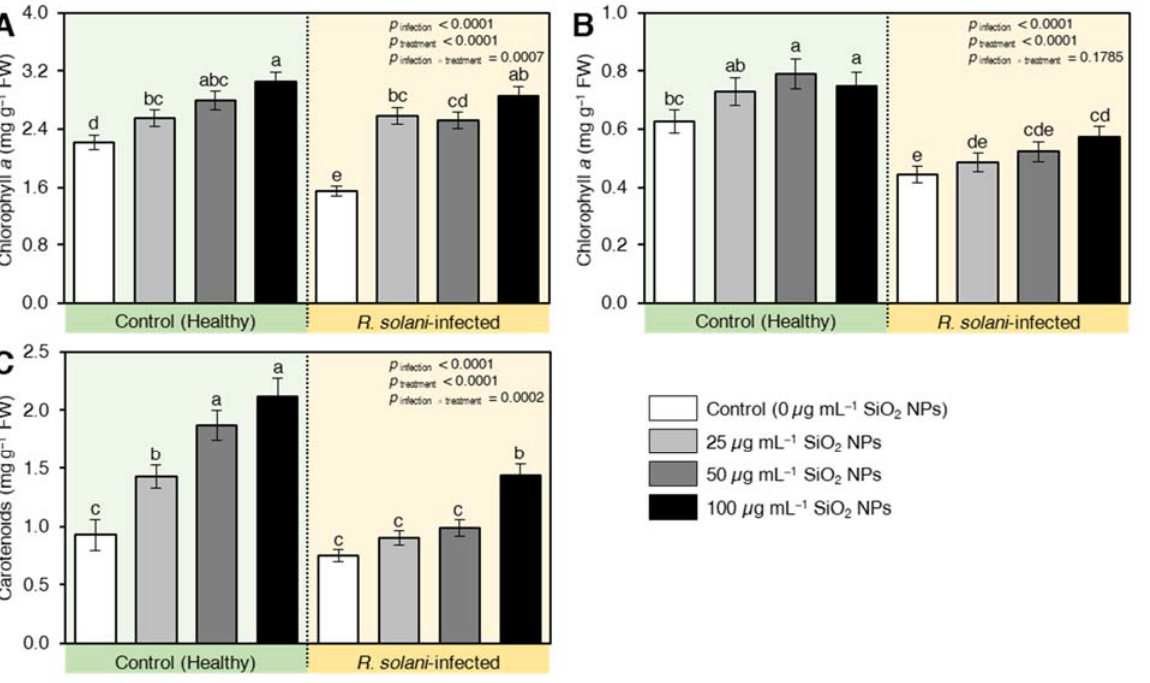
Figure 6. Effect of silicon dioxide nanoparticles (SiO 2 NPs) on the content of photosynthetic pigments of wheat seedlings infected by R. solani. ( A ) Chlorophyll a (mg g − 1 FW), ( B ) Chlorophyll b (mg g − 1 FW), and ( C ) Carotenoids (mg g − 1 FW). Data presented are means ± standard deviation (mean ± SD) of five biological replicates. Different letters indicate statistically significant differences among treatments, while the same letters signify no significant differences between them according to Tukey’s honestly significant difference test ( p < 0.05).